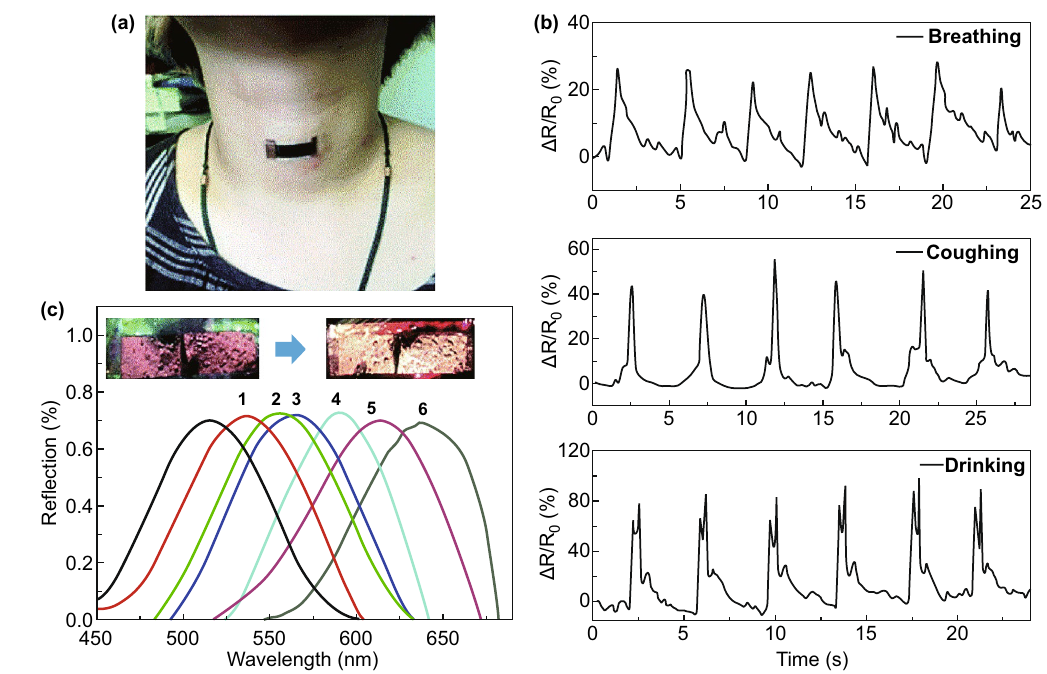
Fig. 27 a In-situ monitoring and detection of human throat motions and sweat during motion. b Electrical resistance (Δ R / R 0 ) change patterns of human throat laryngeal prominence under different motions as breathing, coughing, and drinking. c Reflection spectra of sensor detection human artificial sweat (1–6: 30–680 mM NaCl concentrations). Reproduced with permission from Ref. [165] Copyright © 2018, The Royal Society of